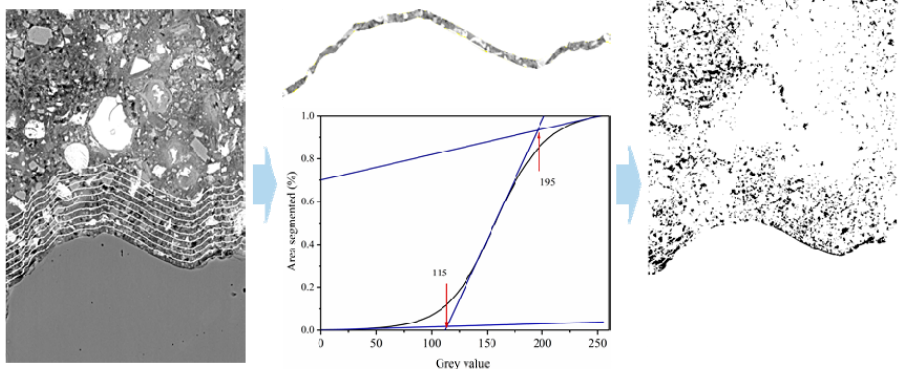
Figure 4. Schematic of BSE imaging process including strip delineation, segmentation, and porosity determination.